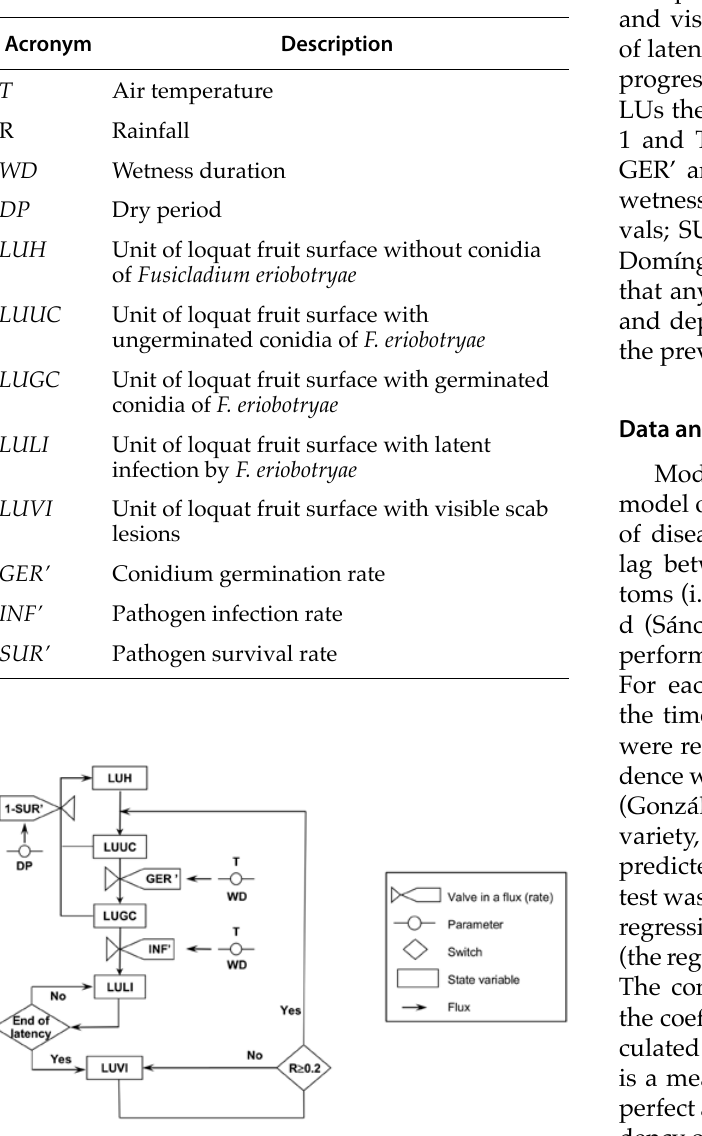
Table 1. List of variables used in a loquat scab model, adapted from González-Domínguez et al. (2014b).